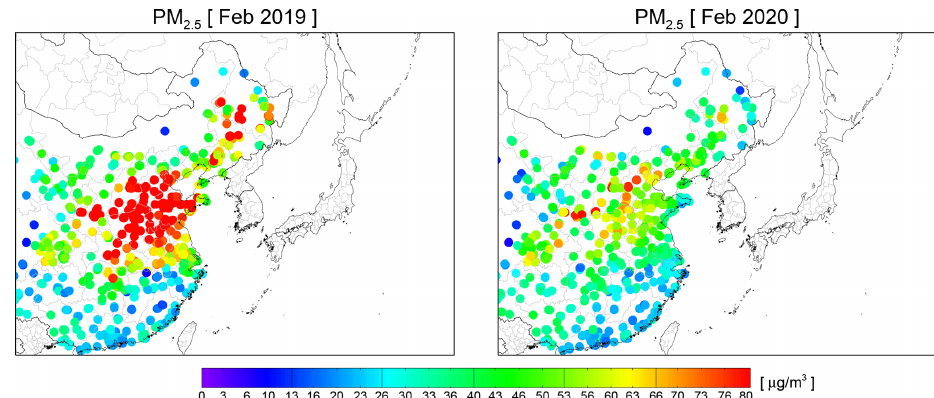
Figure 1. Geographical coverage of modeling domain and surface-monitoring sites. Monthly mean surface PM 2 . 5 concentrations in February 2019 and February 2020 are shown. Table 1. Physical options for meteorological and chemical simulations.